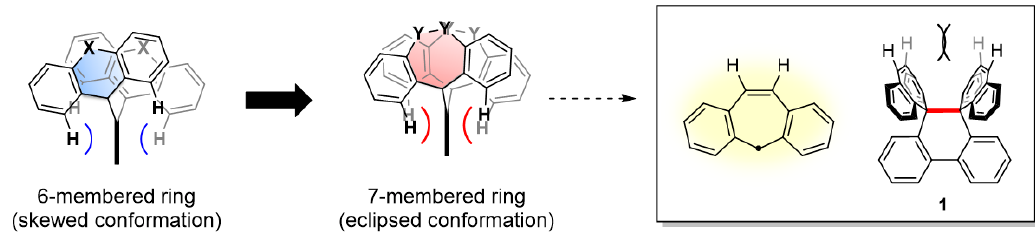
Figure 3. Molecular design of Ar 4 DHP 1 with two spiro(dibenzocycloheptatriene) units.